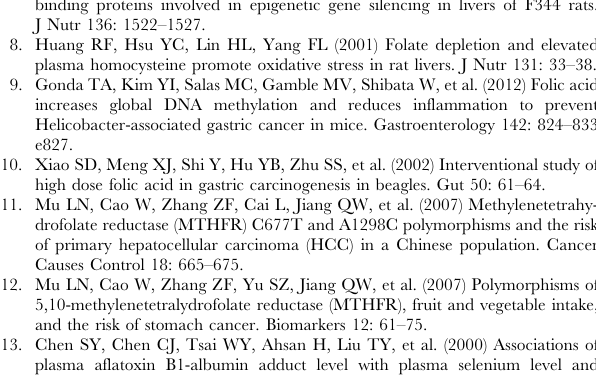
Table S1 Results of the associations between SNPs of MTHFR, MTR, MTRR, DNMT1, and ALDH2 genes and cancers of esophagus, stomach, and liver, stratified on plasma folate levels. Table S2 Results of the associations between SNPs of MTHFR, MTR, MTRR, DNMT1, and ALDH2 genes and cancers of esophagus, stomach, and liver, stratified on plasma vitamin B12 levels. Table S3 Results of the associations between SNPs of MTHFR, MTR, MTRR, DNMT1, and ALDH2 genes and cancers of esophagus, stomach, and liver, stratified on plasma homocysteine levels. Table S4 Results of the associations between SNPs of MTHFR, MTR, MTRR, DNMT1, and ALDH2 genes and cancers of esophagus, stomach, and liver, stratified on tobacco smoking status. Table S5 Results of the associations between SNPs of MTHFR, MTR, MTRR, DNMT1, and ALDH2 genes and cancers of esophagus, stomach, and liver, stratified on alcohol drinking status. Table S6 Results of the associations between SNPs of MTHFR, MTR, MTRR, DNMT1, and ALDH2 genes and stomach cancer, stratified on H. Pylori infection status, and on liver cancer, stratified on HBsAg status and plasma aflatoxin B1 albumin adduct